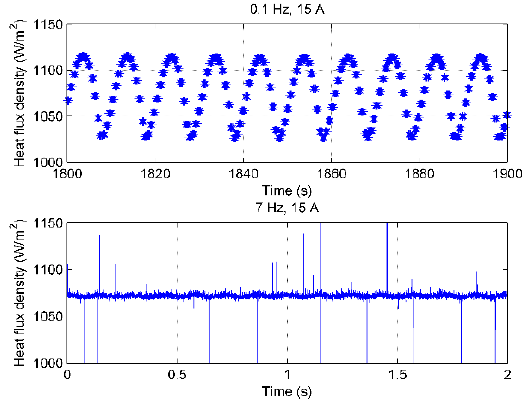
Figure 11. Heat flux at 0.1 Hz and 7 Hz with 15 A source current. Energies 2016 , 9 , 456